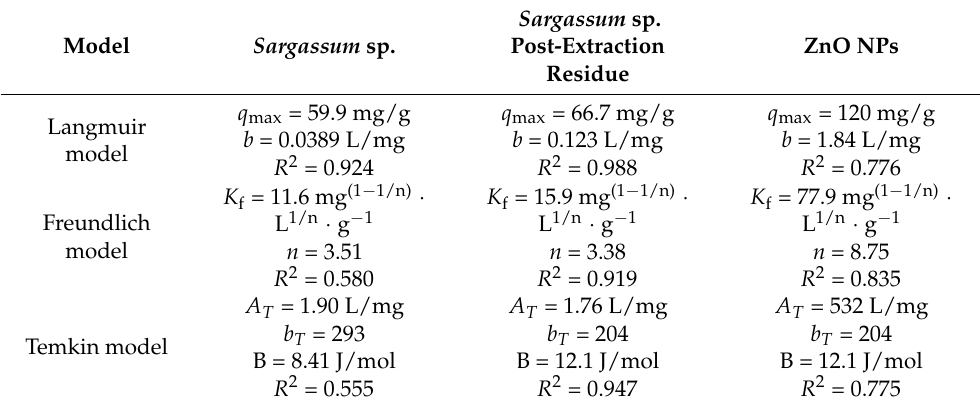
Table 6. Calculated parameters of isotherm models for the tested sorbents under the selected conditions: C 0 25–300 mg/L, C S 1.0 g/L, and pH 5.0.